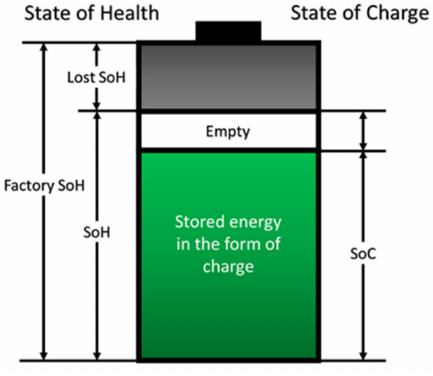
Figure 19. SoH and SoC.